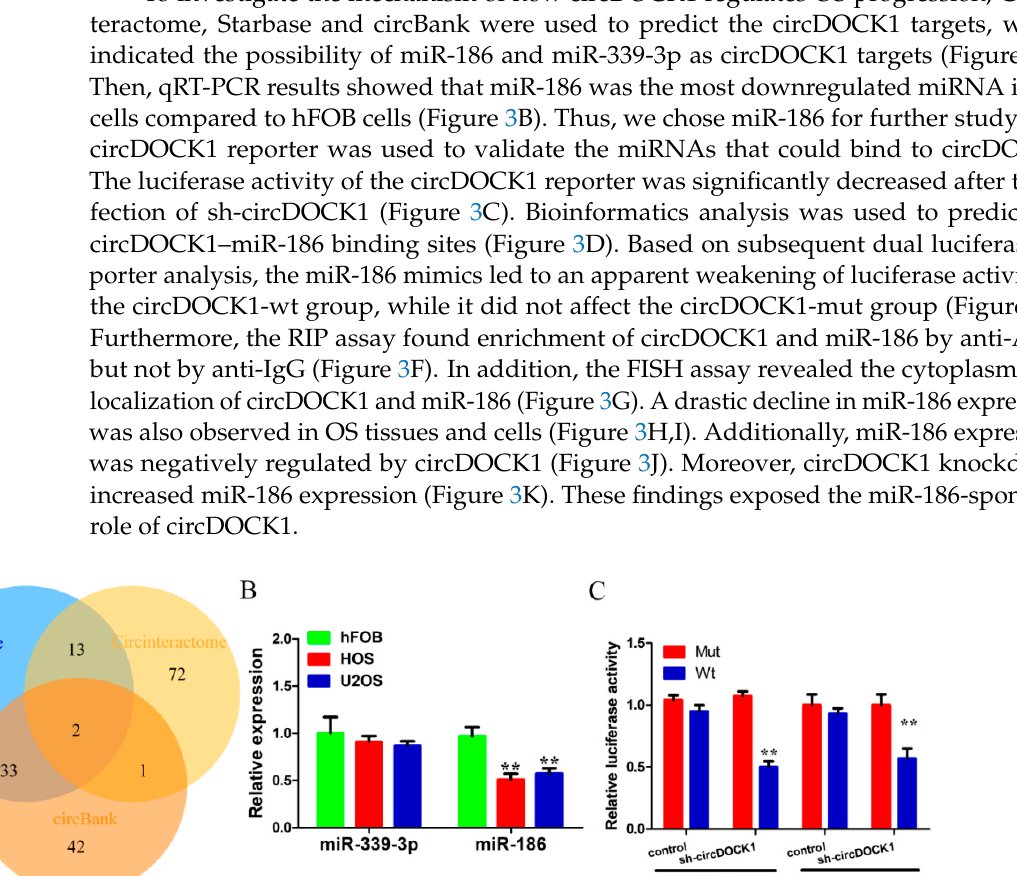
Figure 3. CircDOCK1 acts as a sponge for miR-186. ( A ) Bioinformatics analysis outcomes predicting the circDOCK1 targets. ( B ) The expressions of two target miRNAs in OS cell lines. ( C ) Luciferase activity of the circDOCK1 reporter after transfection of sh-circDOCK1 in OS cells. ( D ) The circDOCK1–miR-186 binding sites were predicted using bioinformatics, and the red sequence means mutant binding sequences. ( E ) Luciferase activity outcome on co-transfected OS cells. ( F ) RIP assay outcome on the binding correlation of circDOCK1 with miR-186. ( G ) FISH assay outcome suggests the cytoplasmic co-localization of circDOCK1 and miR-186. ( H , I ) The OS tissue and cellular levels of MiR-186 were markedly decreased. ( J ) The miR-186 level was negatively regulated by circDOCK1. ( K ) Silencing circDOCK1 increased miR-186 expression. * p < 0.05, ** p < 0.01. 3.4. Knockdown of miR-186 Partly Reverses the Effect of sh-circDOCK1 on OS Progression We used sh-circDOCK1 and miR-186 inhibitors to co-transfect the OS cells in order to explore the association of circDOCK1 with miR-186. MiR-186 expression was elevated